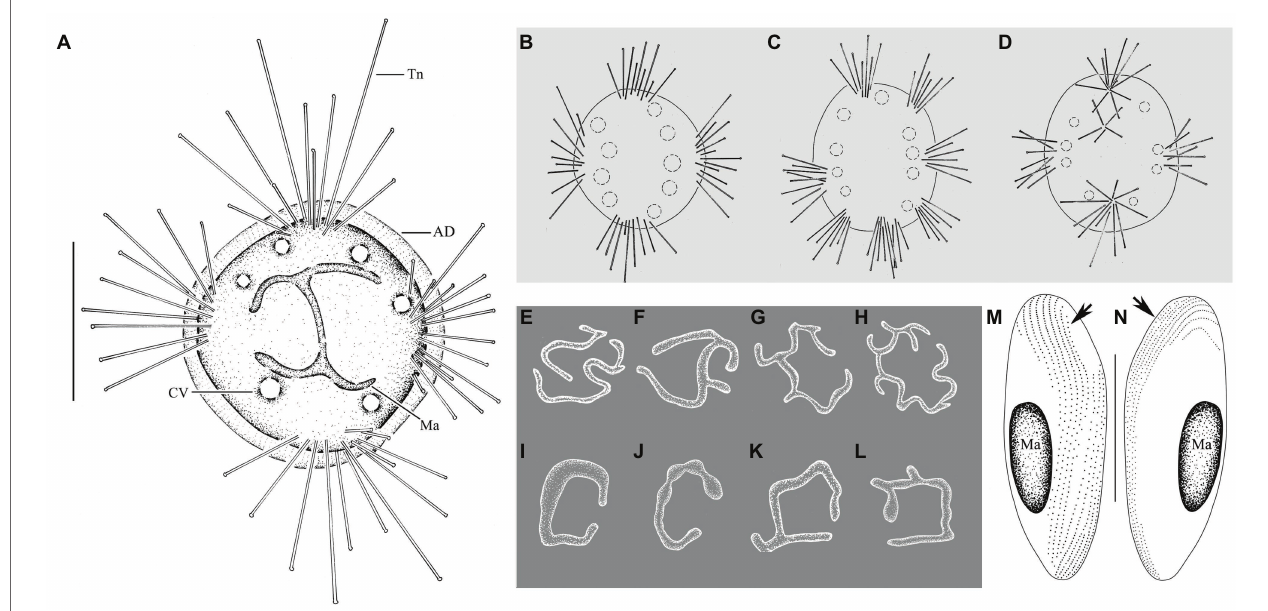
FIGURE 2 | Cyclophrya magna Gönnert, 1935 from life (A–D) and after protargol impregnation (E–L) as well as its swarmer after protargol impregnation (M,N) . (A) Cyclophrya magna in vivo . (B–D) Different number of tentacle fascicles and contractile vacuoles. (E–L) Different shapes of macronuclei. (M,N) Views of swarmer, arrows to show somatic kineties. AD, adhesive disc; CV, contractile vacuole; Ma, macronucleus; Tn, tentacle. Scale bars = 50 μ